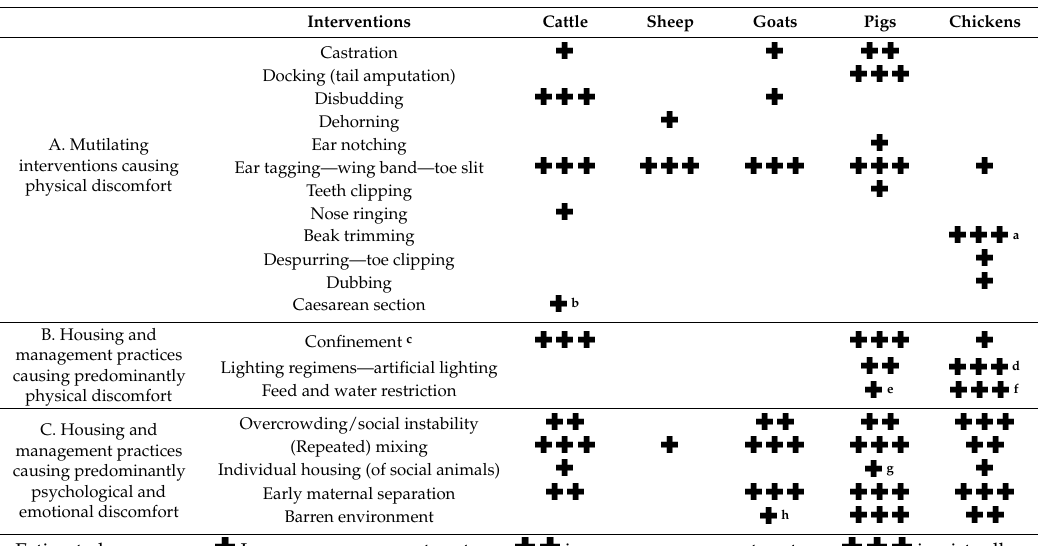
Table 1. Mutilating and damaging interventions and housing/management practices, applied sporadically or routinely, which have the potential to impair farm animal welfare (a summary inspired by